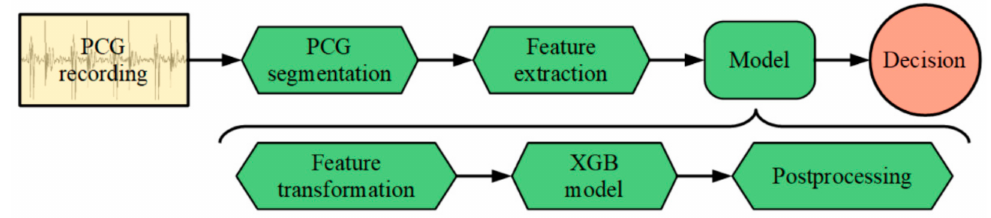
Figure 2. The pipeline of phonocardiogram (PCG) processing by artificial intelligence (using